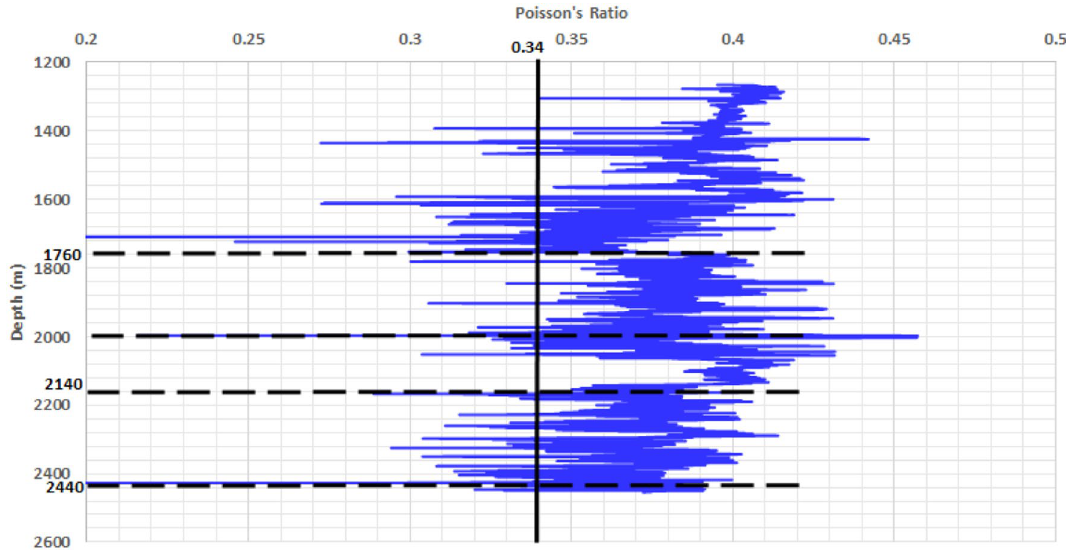
Fig. 21 Poisson’s ratio of Field